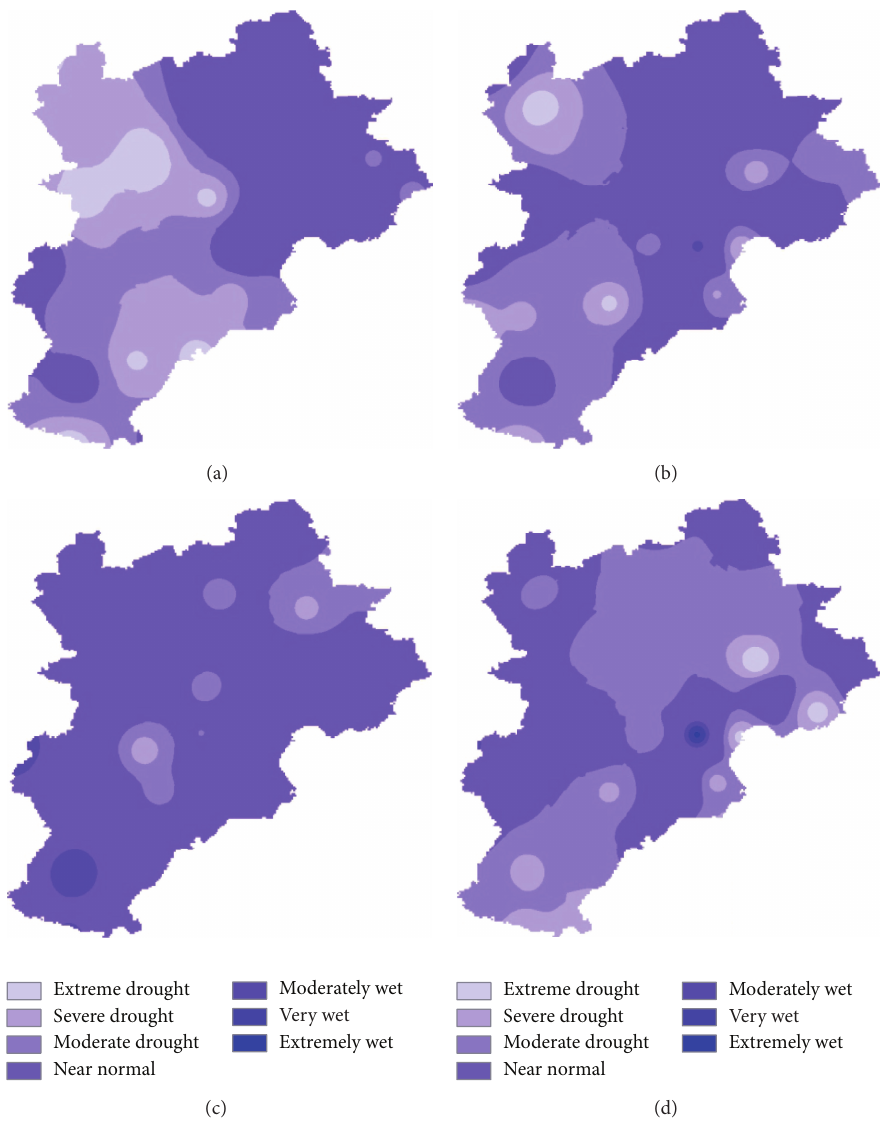
Figure 5: Spatial distribution of RDI-12 over the course of the years (a) 1965; (b) 1997; (c) 2000; and (d) 2002.